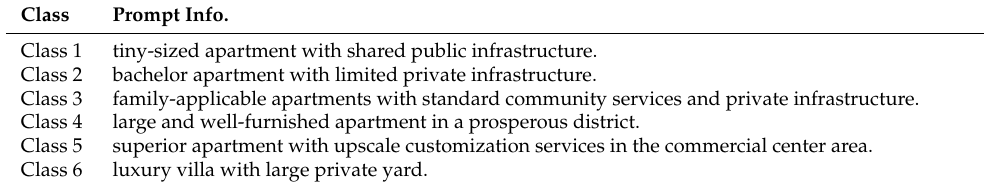
Table 2. Prompt information for text generation